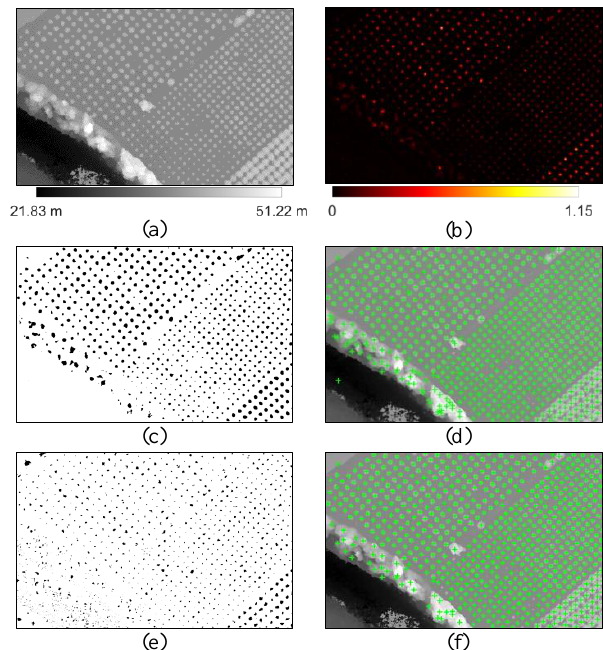
Figure 2. (a) DSM of test area #1, (b) aggregated orientation symmetry ( O S ) for α i = 4, 5, and 6, (c) detected regions ( R I ), (d) the green “+” corresponds to the centroid location of each R I , (e) the LM regions found (h = 0.2 m), and (f) filtered centroid locations using LM